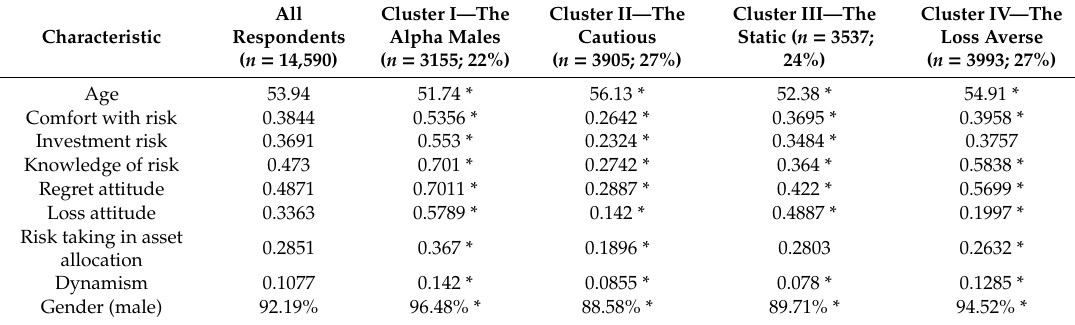
Table 4. Risk profile characteristics of each